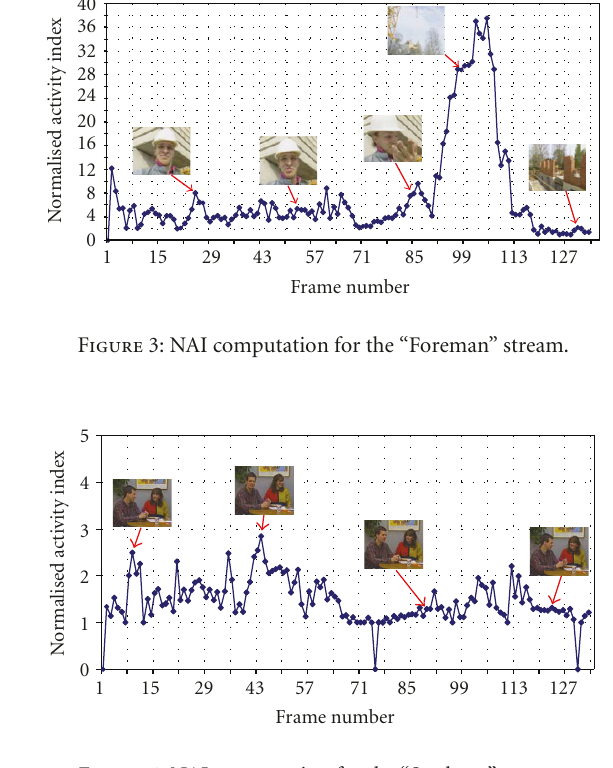
Figure 4: NAI computation for the “Students”